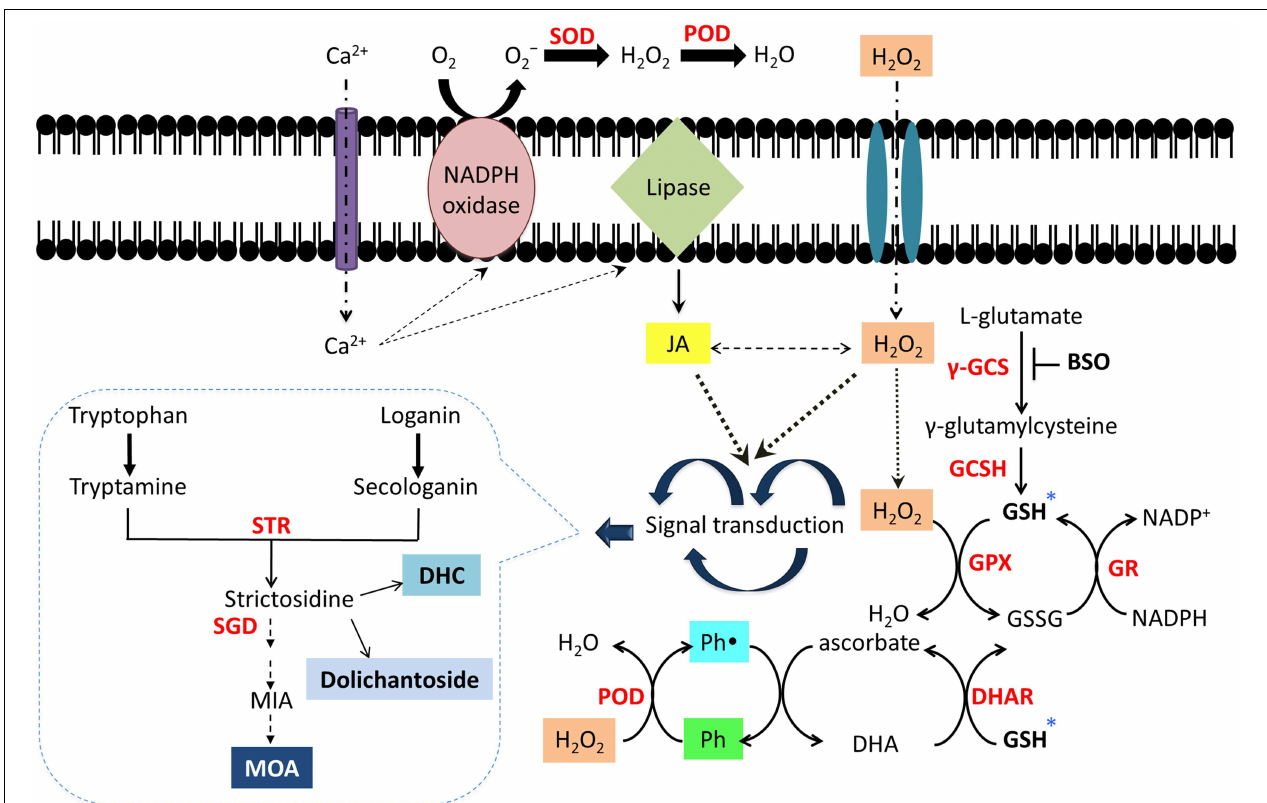
ascorbate or GSH are unable to be regenerated into the cell (Guo and Ohta, 1993 ). In order to maintain the redox equilibrium in the cell, production of antioxidant compounds as polyphenols and alkaloids (secondary metabolites) could be induced ( Ramos-Valdivia et al., 2012). Polyphenols (Ph) can detoxify H 2 O 2 as electron donors by peroxidases (PDO), which results in formation of the respective phenolic radical (Ph • ). This species can be regenerated by a non-enzymatic reaction with ascorbate. Dehydroascorbate (DHA) may be reduced back to ascorbate by a dehydroascorbic acid reductase (DHAR) (Ferreres et al., 2011 ). Superoxide dismutase (SOD); glutathione peroxidase